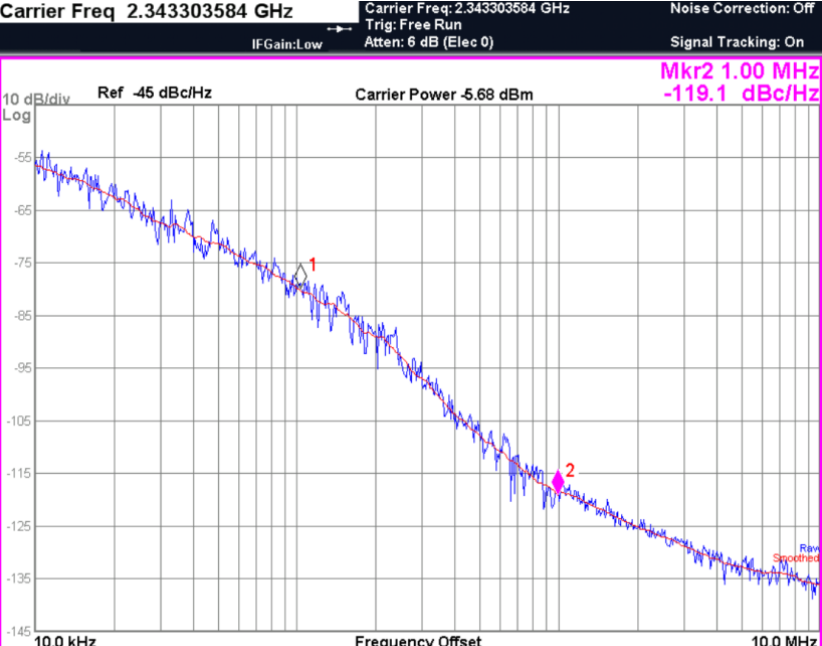
Figure 17. Measured phase noise performance of free-running RO.